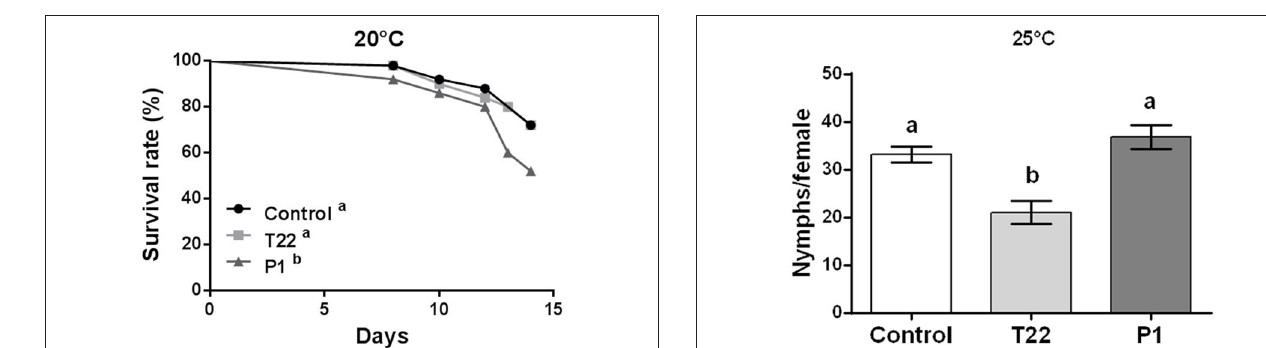
FIGURE 6 | Aphid survival rate at 20 ◦ C. Macrosiphum euphorbiae reared on P1-tomato showed higher mortality compared to aphids reared on T22- and Control-tomato plants. Different letters indicate a significant difference (Log-rank test, P < 0.001).